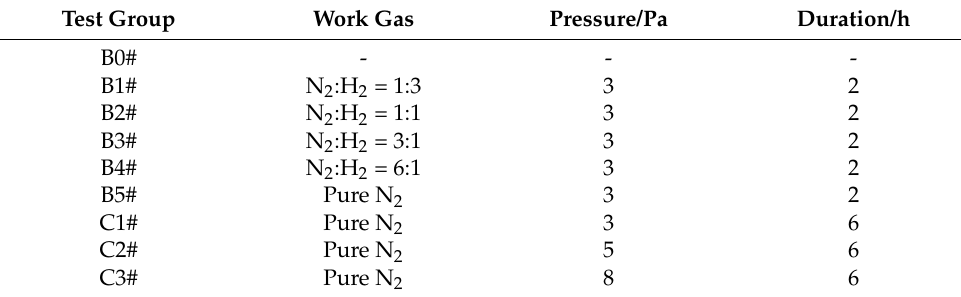
Table 1. Process parameters of the different test